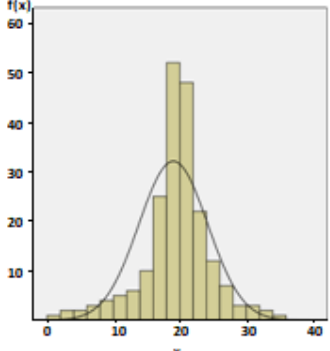
Fig 1a . Close to normal probability distribution [19].